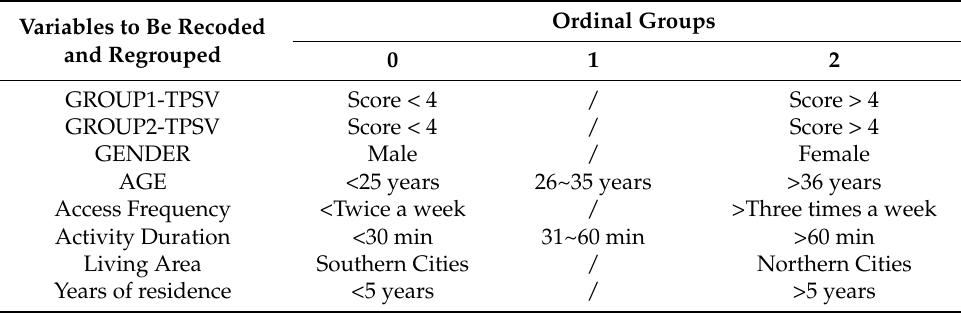
Table 3. Coding and classification of demographic variables and related